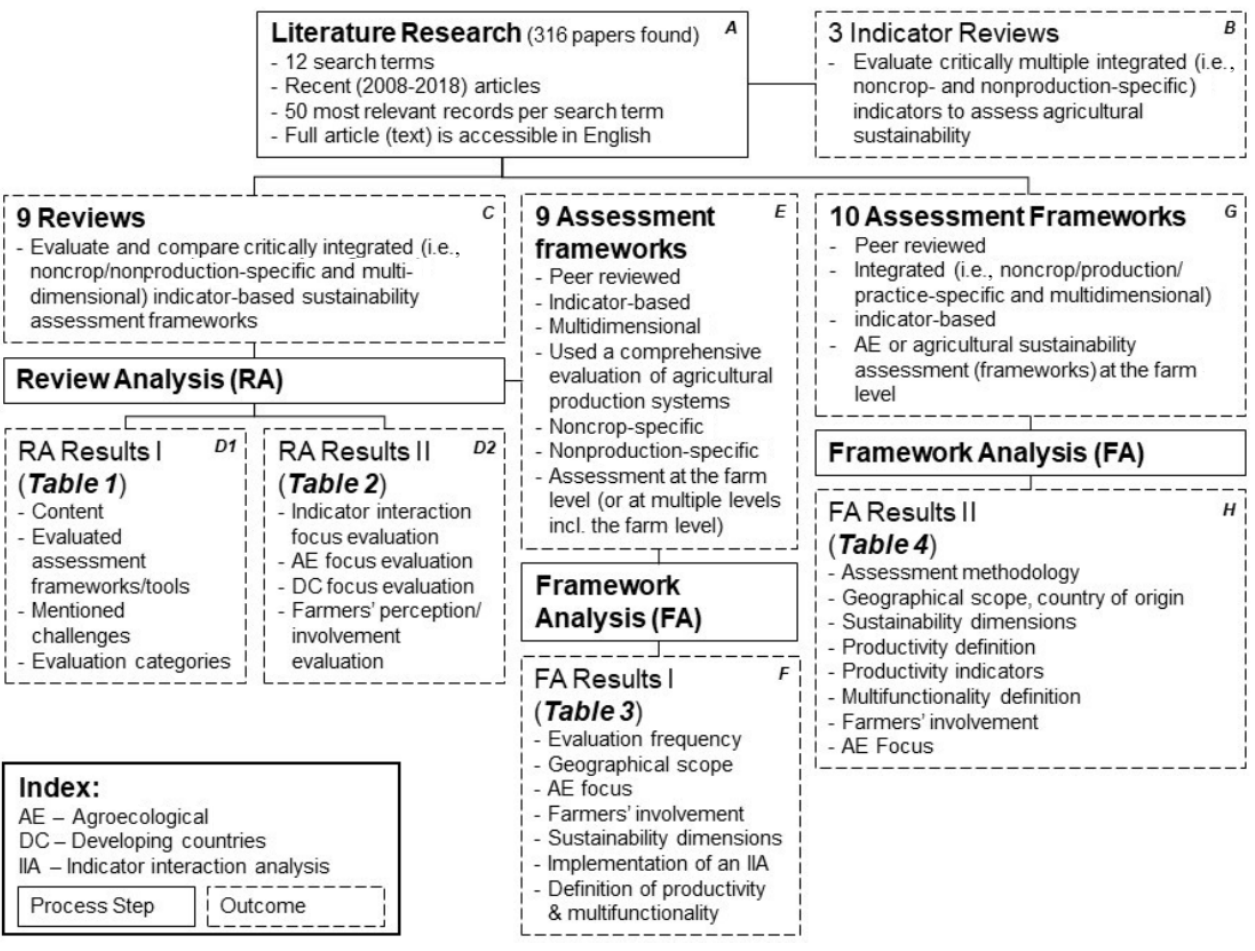
Fig. 1 . Process flow diagram of the conducted literature analysis. For each process step and outcome, selection and evaluation criteria are